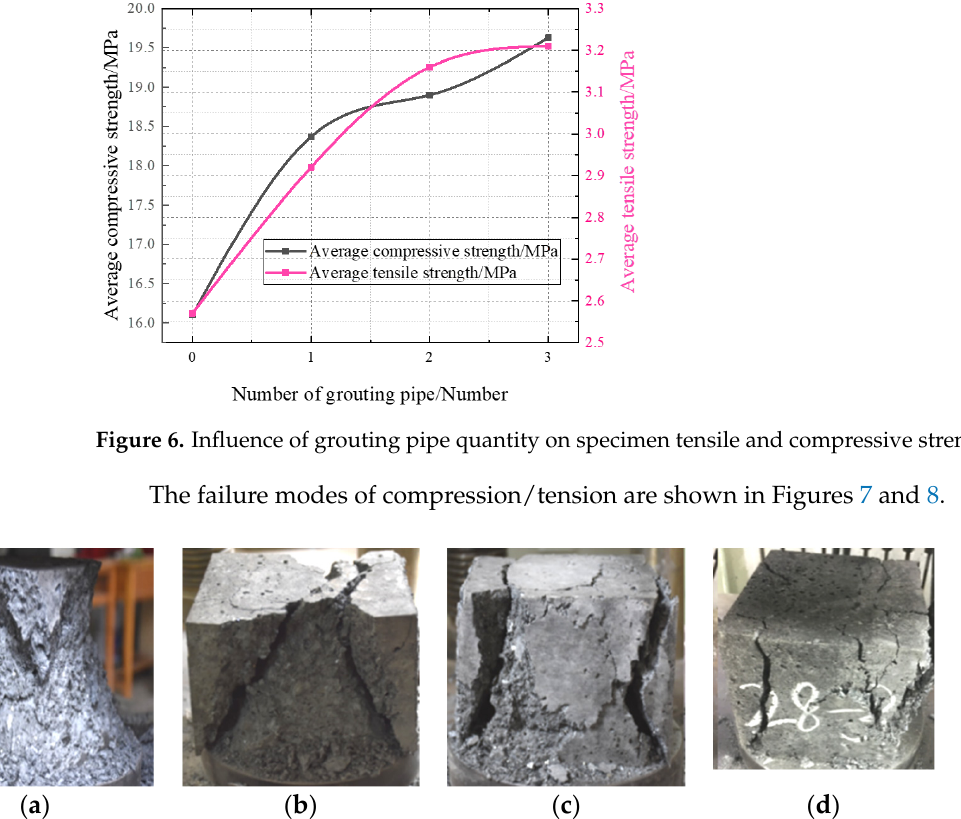
Figure 7. Influence of grouting pipes on compression strength: ( a ) no grouting pipe; ( b ) one grouting pipe; ( c ) two grouting pipes; ( d ) three grouting pipes.